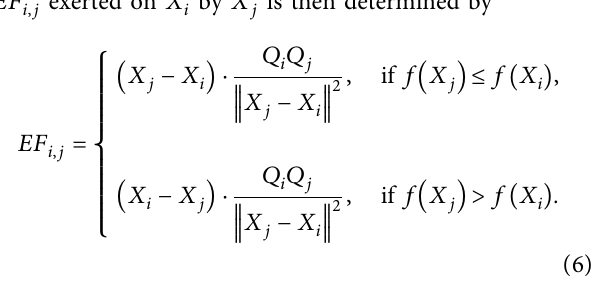
Table 1: Te orthogonal array L